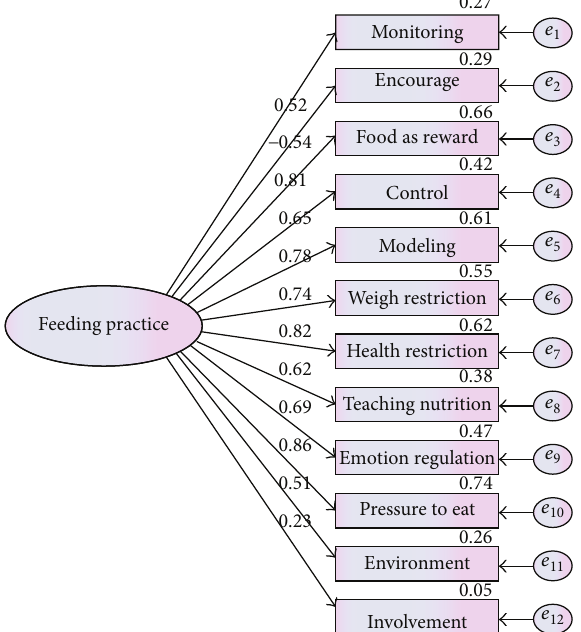
Figure 3: Measurement model for parental feeding practice.